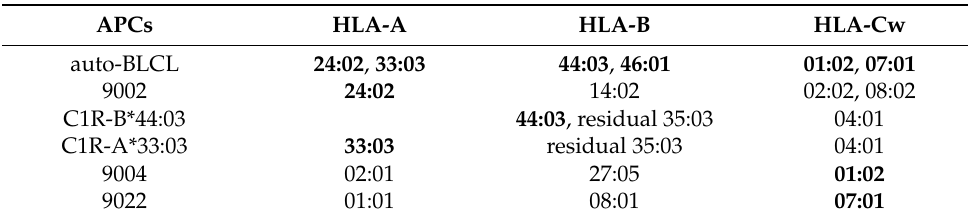
Table 1. HLA information of